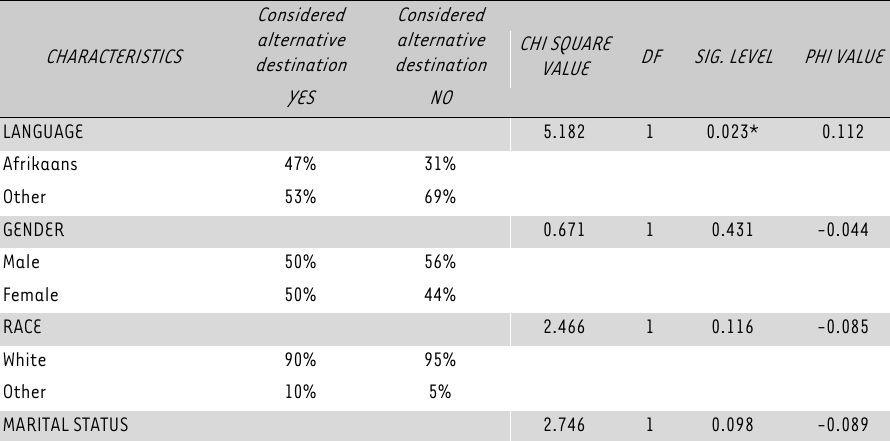
Results of the chi-square